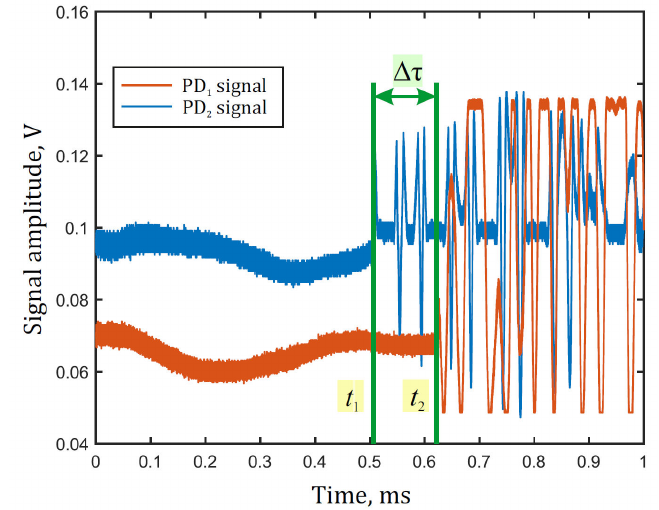
Figure 12. Measured signal plots for two